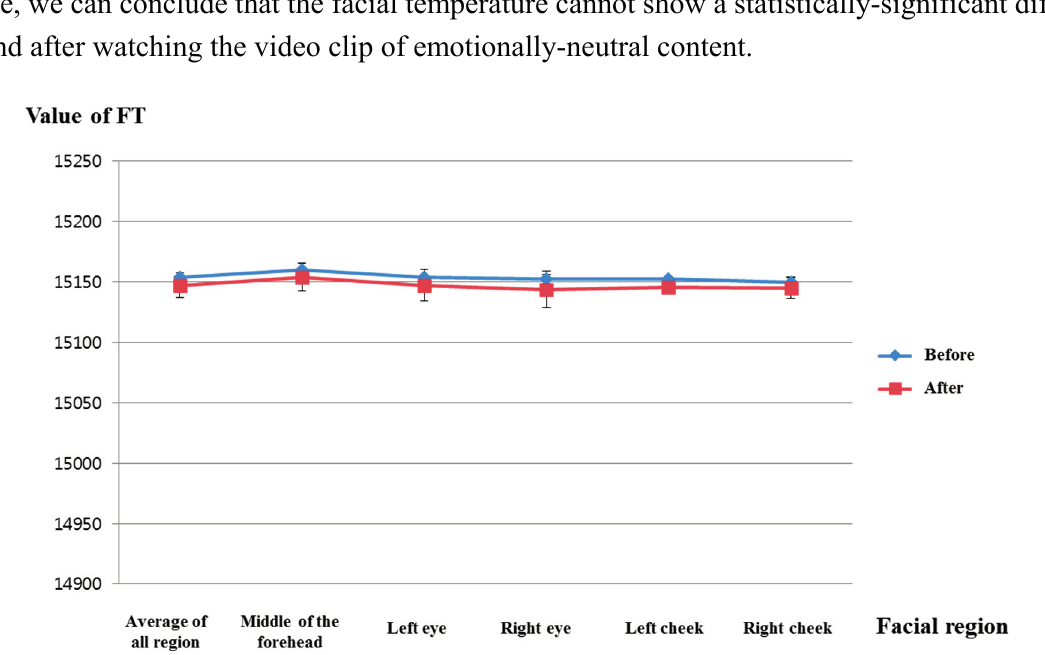
Figure 18. Comparisons of the facial temperature of facial feature regions before and after watching the video clip of emotionally-neutral content to the subjects (FT is facial